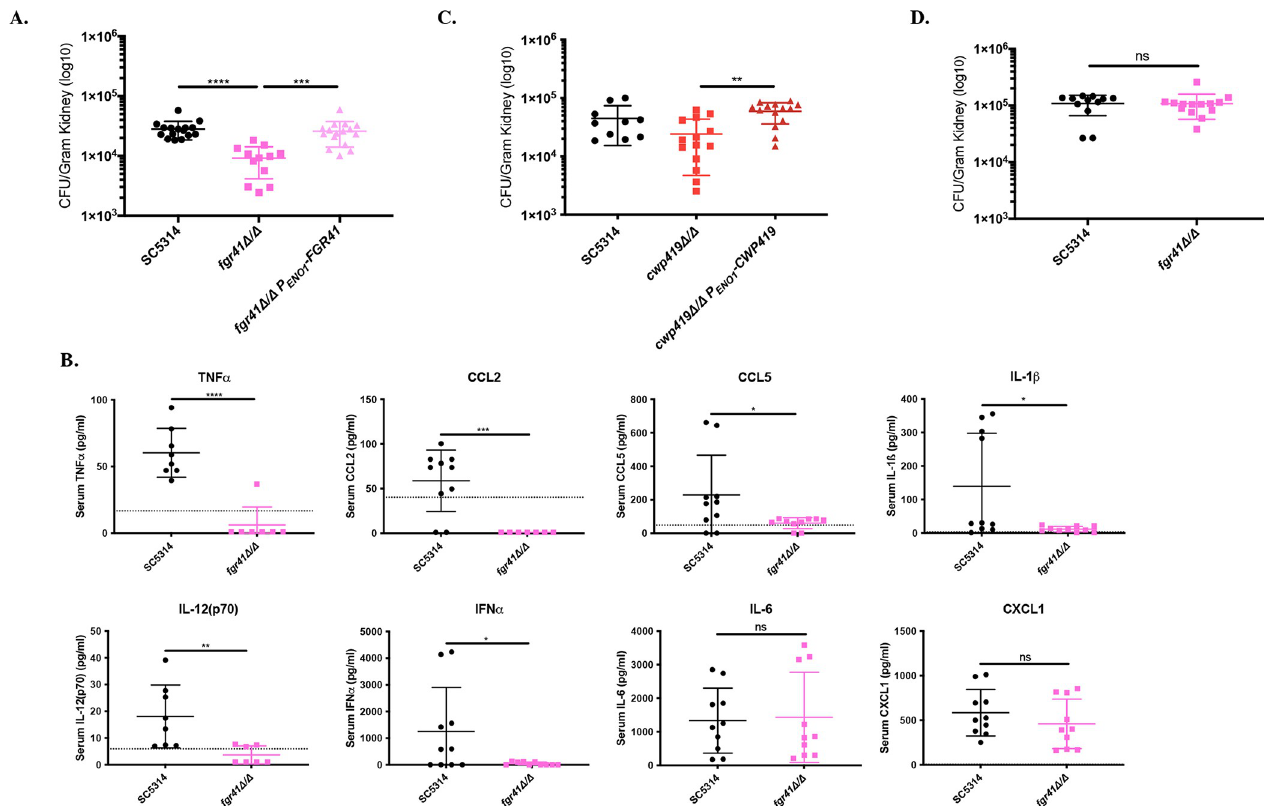
Fig 6. Loss of FGR41 attenuates virulence in a host immune system dependent manner. (A) ICR mice were intravenously infected with 1x10 6 cells of C . albicans wild-type (SC5314), the fgr41 Δ / Δ mutant, or the fgr41 Δ / Δ P ENO1 -FGR41 reintegrant strain, and kidneys were subsequently harvested 4 days post infection (d.p.i.) to assess fungal burden. (n = 7–8 mice per strain)( ��� p < 0.0005, ���� p < 0.0001, by Kruskal-Wallis test with Dunn’s multiple comparisons post- hoc analysis). (B) Serum collected 4 d.p.i. was assessed via flow cytometry using the LEGENDplex cytokine bead-based array kit to measure circulatory cytokine levels following infection with either the C . albicans wild-type (SC5314) or the fgr41 Δ / Δ mutant. (n = 5 mice)(The dashed line across the x-axis represents the limit of detection.)(ns = not significant, � p < 0.05, �� p < 0.01, ��� p = 0.0005, ���� p < 0.0001, by either student’s t-test or Mann-Whitney test). (C) ICR mice were intravenously infected with 1x10 6 cells of C . albicans wild-type (SC5314), the cwp419 Δ / Δ mutant, or the cwp419 Δ / Δ P strain, and kidneys were subsequently harvested 4 d.p.i. to assess fungal burden. (n = 6–8 mice per strain)( �� p < 0.01, by one-way ANOVA). (D) ICR mice were immunosuppressed with recurring intraperitoneal injections of 150mg/kg of cyclophosphamide every 3 days starting 4 days prior to infection. At day 0, mice were intravenously injected with 1x10 4 cells of C . albicans wild-type (SC5314) or the fgr41 Δ / Δ mutant and kidneys were harvested 3 days post infection (d.p.i.) to assess fungal burden. (n = 6–7 mice)(ns = not significant, by Mann-Whitney